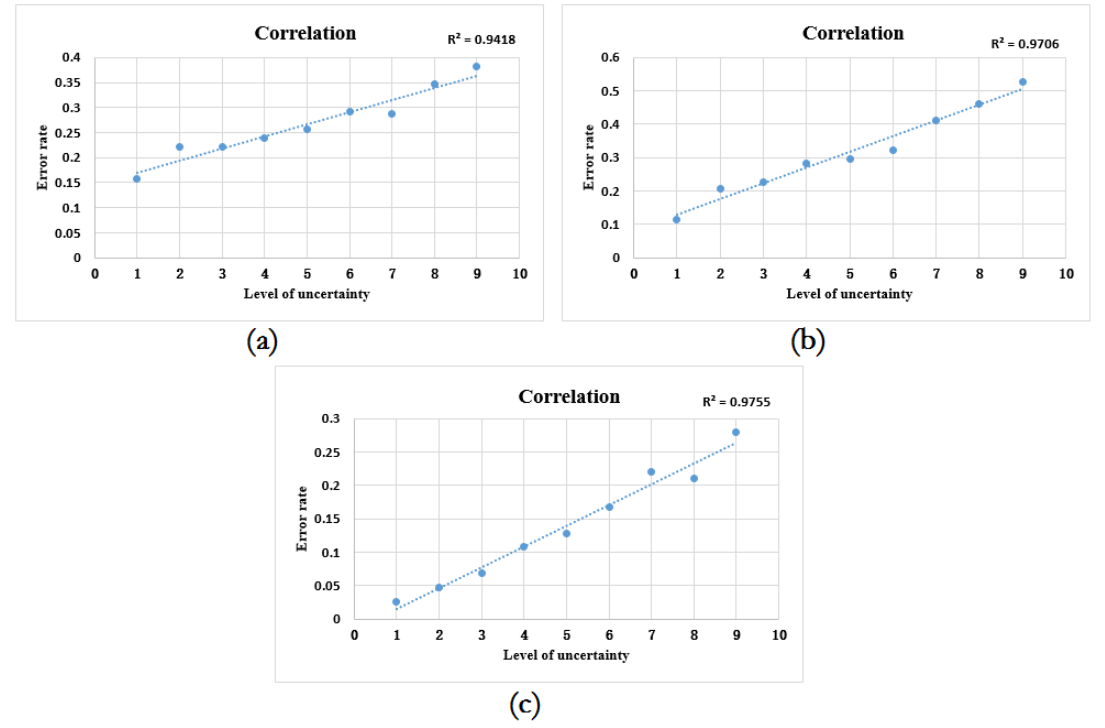
Figure 12. Scatter plots and fitted curves of the levels of uncertainty and classification error rates: ( a ) Vaihingen image, ( b ) Beijing2 image, and ( c ) Potsdam image. ( x -axis: levels of uncertainty, y -axis: classification error rates) Table 2. Fitted curve equations and correlation coefficients